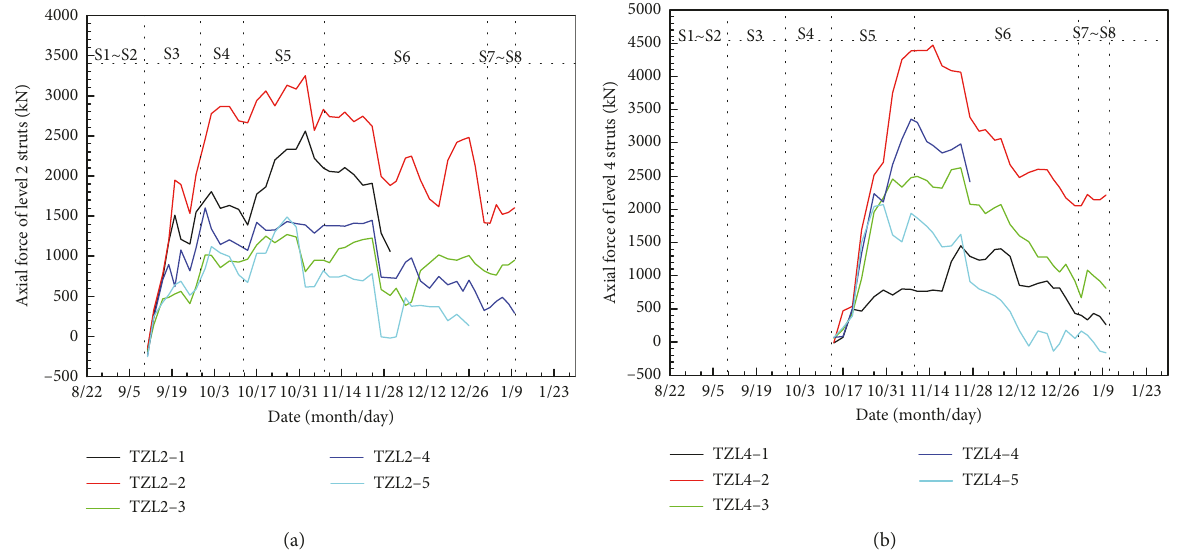
Figure 14: Development of axial force of struts. (a) Level 2. (b) Level